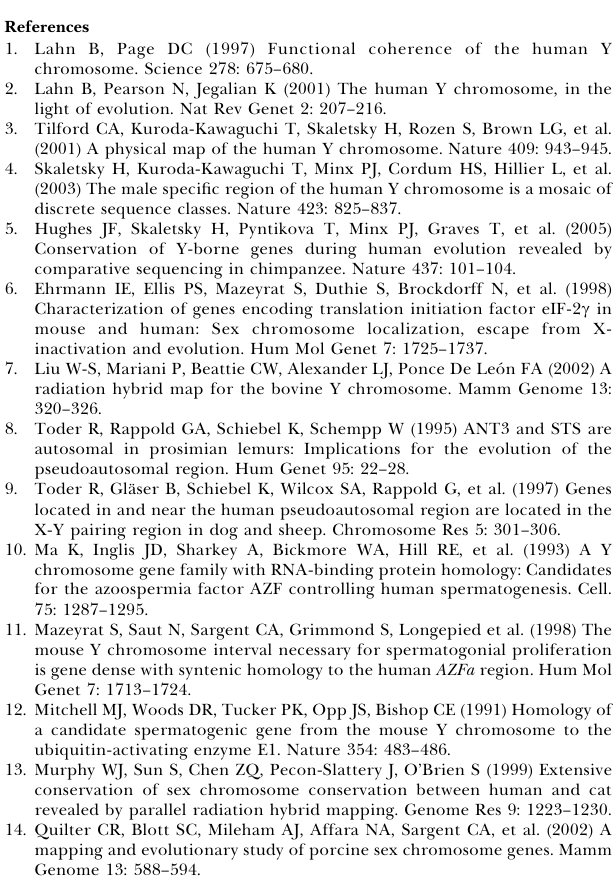
Table S1. Primers Used for This Study Table S2. Sequence Divergence between X/Y and Y-Autosome (Y/A) Gene